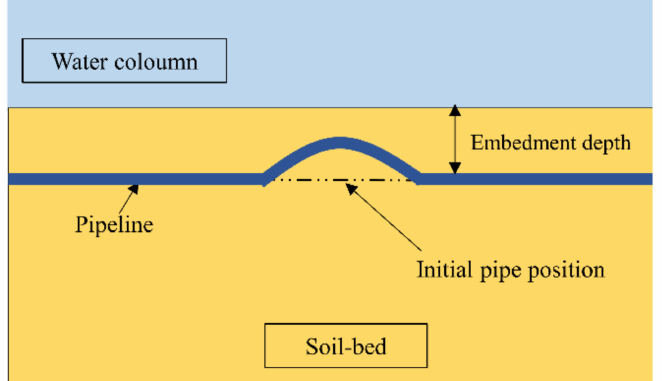
Figure 10. Schematic diagram of global upheaval buckling of buried